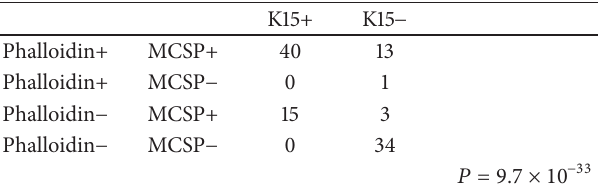
Table 2: Three-way association of APM and stem cell markers.